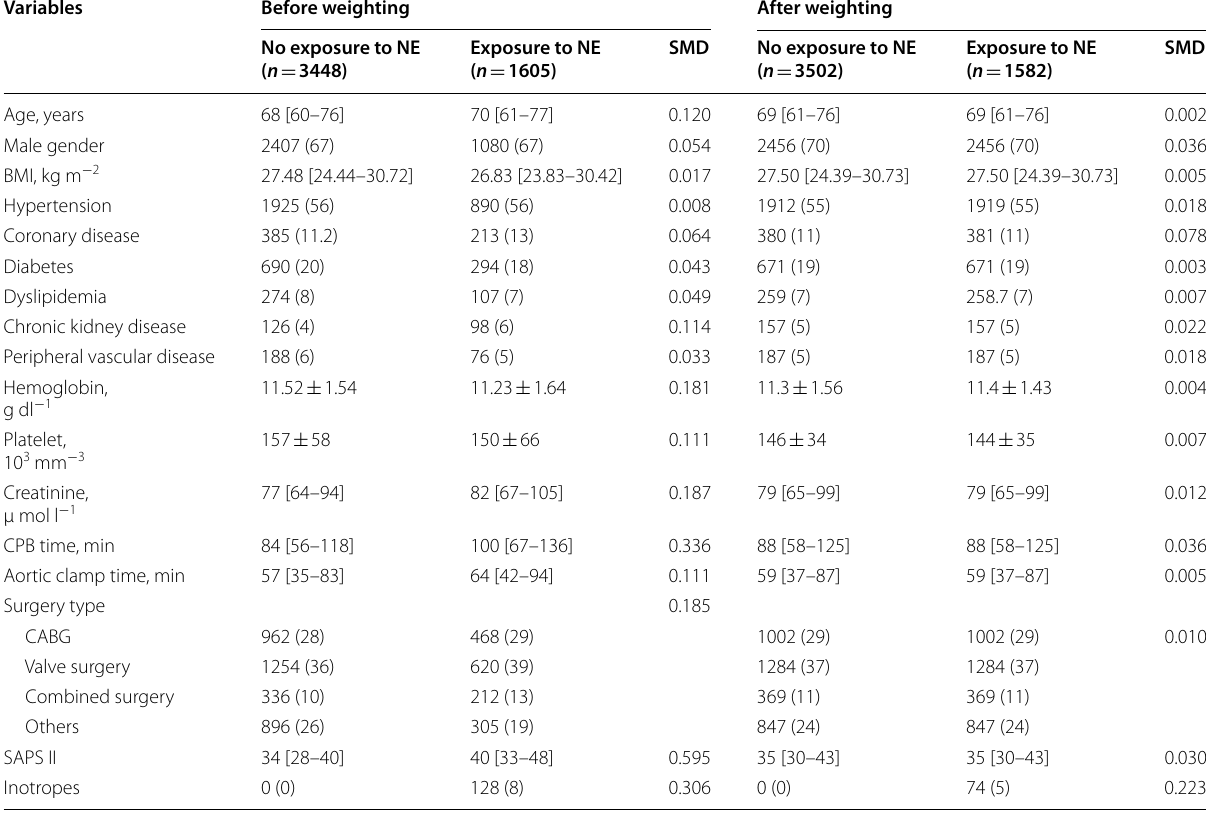
An absolute MSD < 10% was considered to support the assumption of a balance between the groups. SMD: standardized mean differences. Data are presented as medians [interquartile ranges] or as numbers (percentages). NE: norepinephrine, CABG: coronary bypass graft, CPB: coronary bypass, SAPS II: Simplified Acute Physiology Score. Male gender and coronary disease were not selected for the propensity weighting as the P value for their association with acute kidney injury was over 20%